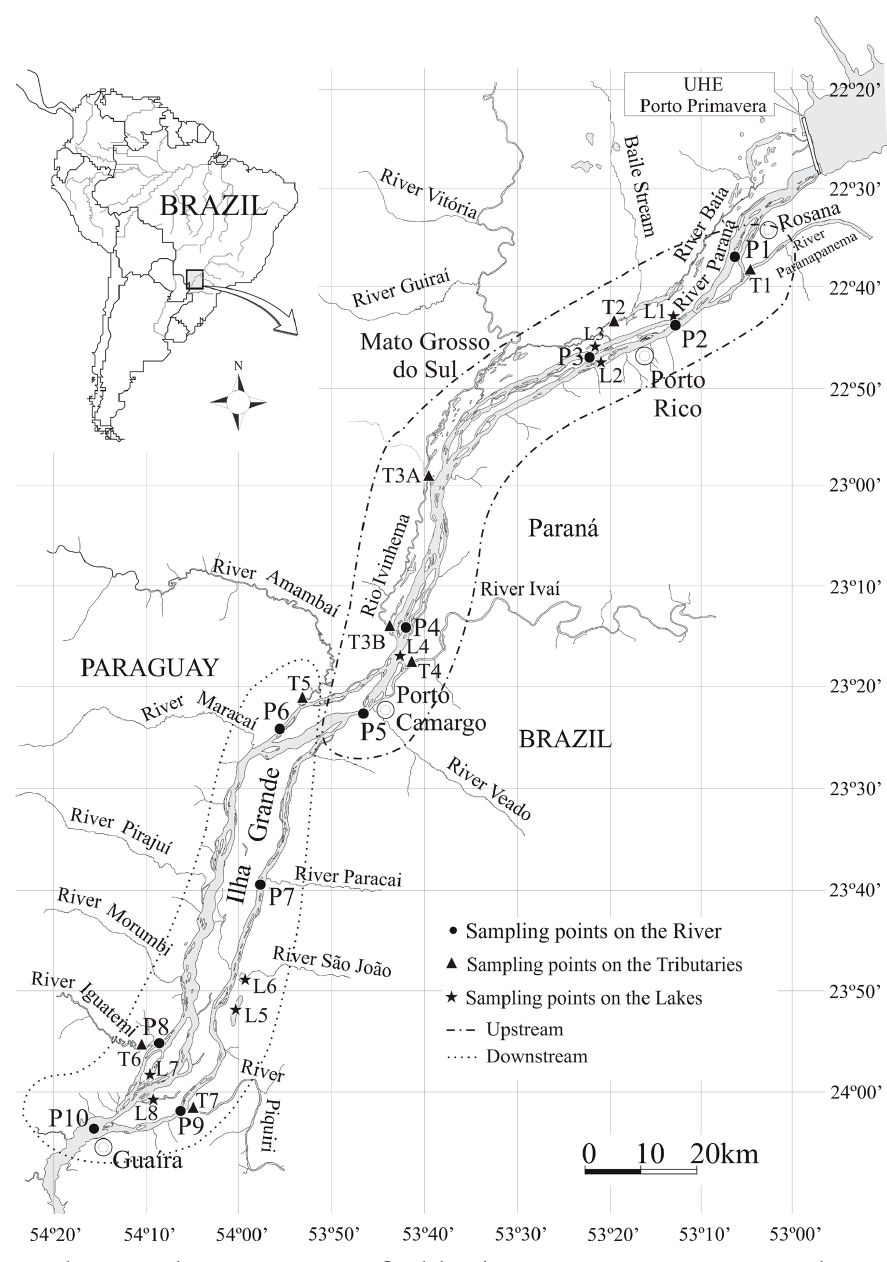
Figure 1. Sampling sites in the Upper Paraná River floodplain, between Porto Primavera reservoir and Itaipu Reservoir. Upstream: stretch directly influenced by Porto Primavera reservoir and the large tributaries of the left river bank; Downstream: stretch influenced by the small tributaries of the right river bank and Itaipu